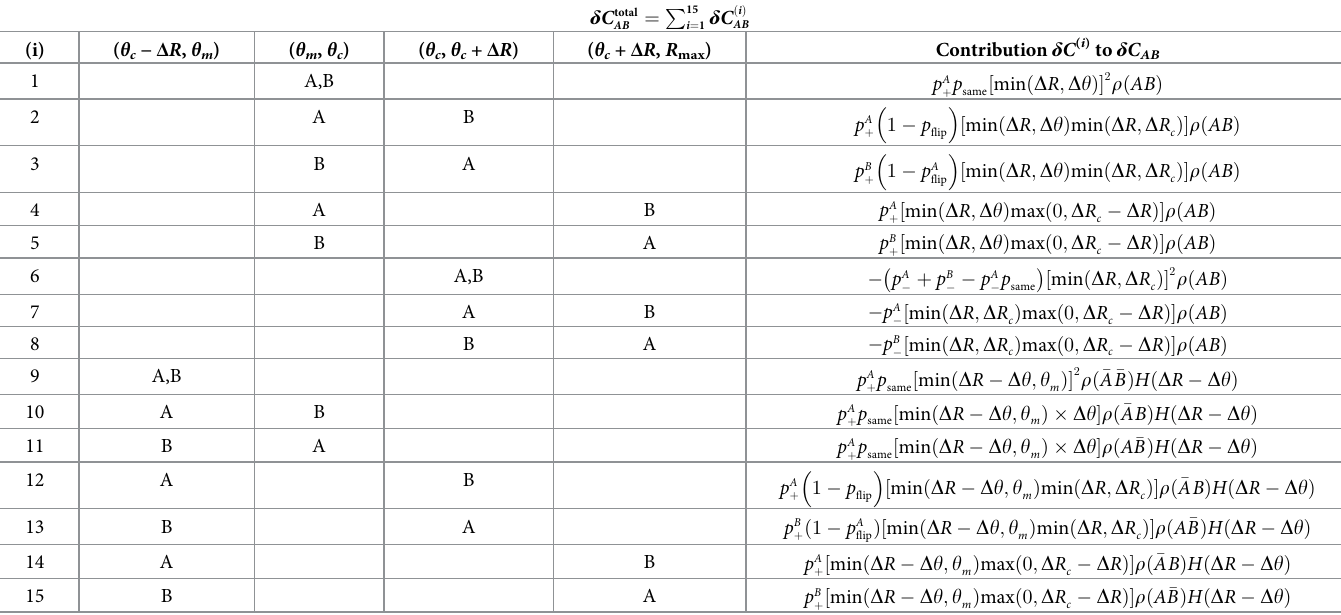
Table 2. All fifteen cases for feedback-driven changes in modules responding to both